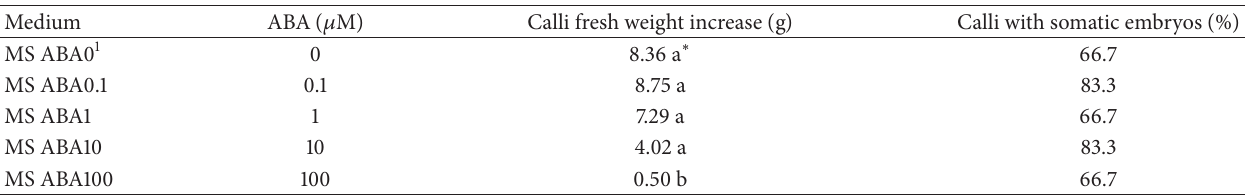
Figure 3: Callus of the cactus C. tenuissima Ritt. forma mostruosa on the media (bar = 0.1mm): (a) without ABA (magnification 1.5 × 10 ) and (b) with a high concentration of ABA (10 𝜇 M; magnification 1.4 × 10 ). Table 2: Effect of ABA on calli fresh weight increase and percentage of somatic embryos regenerated from calli during indirect somatic embryogenesis of C. tenuissima Ritt. forma monstruosa .